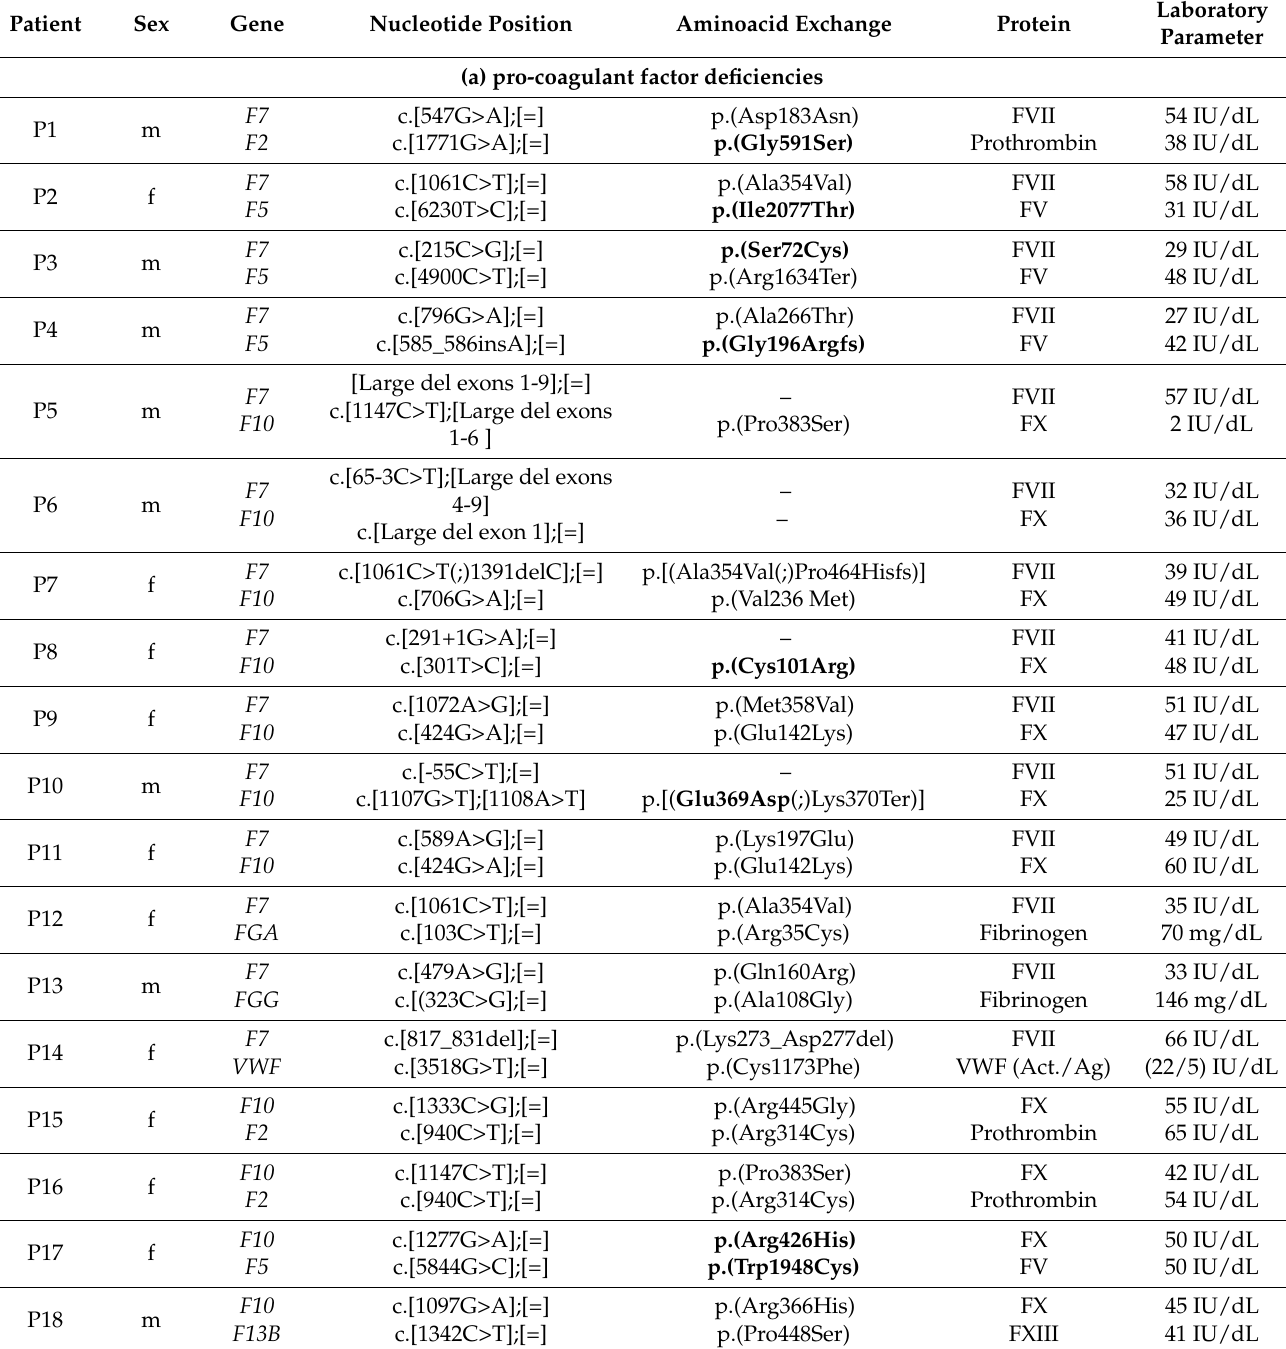
Table 1. Laboratory and genetic features of the familial multiple coagulation factor deficiencies (FMCFDs) arising from single, co-inherited clotting factor genetic defect. FMCFDs due to deficiency ( a ) of two pro-coagulant factors, ( b ) two/three pro- and anti-coagulant factors, ( c ) two anti-coagulant factors (m = male, f = female), IU/dL = international units/deciliter, mg/dL = milligram/deciliter. Novel variants are